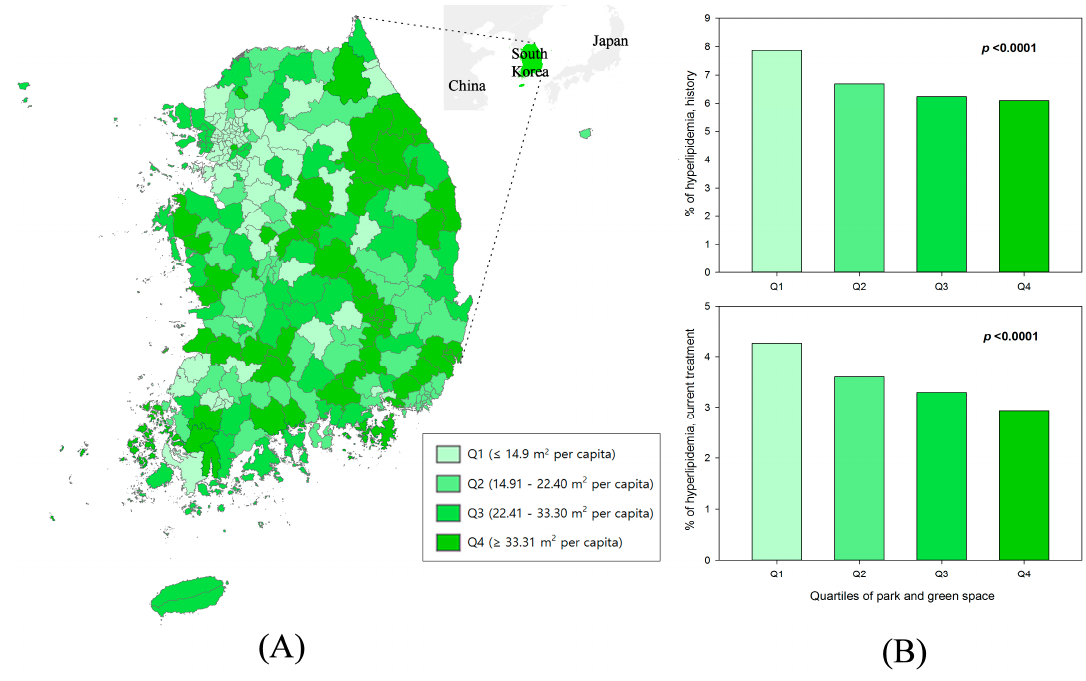
Figure 1. Distribution of park and green areas (m 2 ) per capita ( A ) and percentages (%) of hyperlipidemia against the quartiles of parks and green areas ( B ).